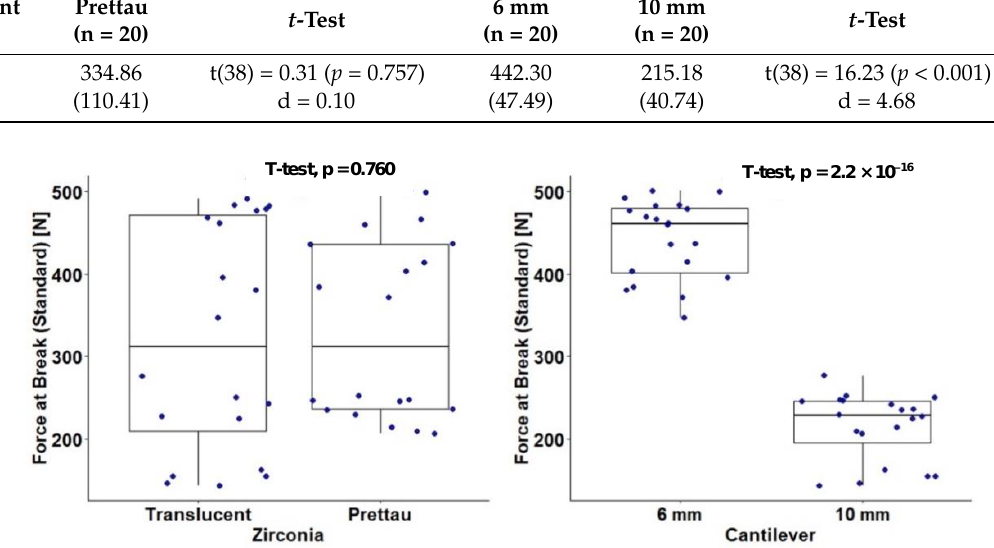
Figure 4. Force at break (standard) (N) according to type of zirconia and cantilever length. Table 3 and Figure 5 show results for the independent effect of the type of zirconia stratified by cantilever length (6 mm and 10 mm). For the 10 mm length, a marginal effect was detected, t(18) = − 2.01 ( p = 0.070), with this having a large effect size, d = 0.90. The Prettau Zirconia components showed a higher mean force at break (M = 232.18, sd = 16.83) than the Ice Zirkon Translucent components (M = 198.18, sd = 50.79). No marginal or